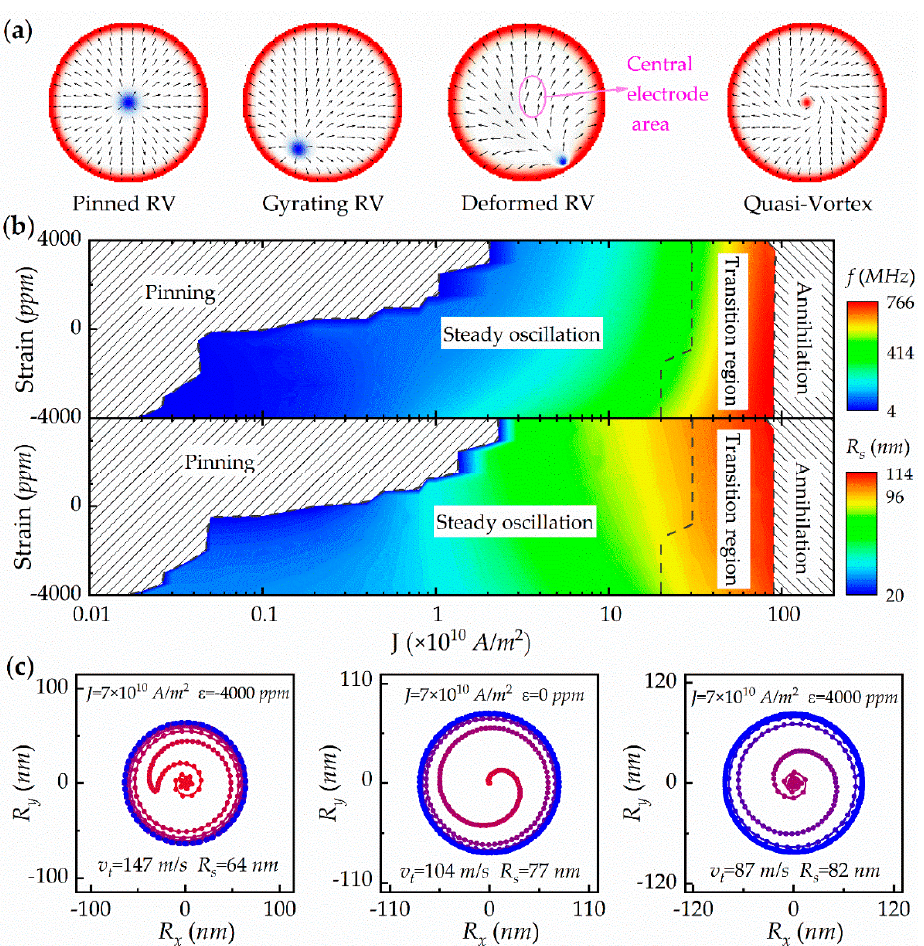
Figure 2. ( a ) Typical topological spin structures in current-driven spin dynamics. ( b ) Phase diagrams of RVC oscillation frequency and oscillation amplitude with respect to current density and piezostrain. ( c ) Trajectory of RVC rotation driven by a fixed current of J = 7 × 10 10 A/m 2 with assistance by different piezostrains.